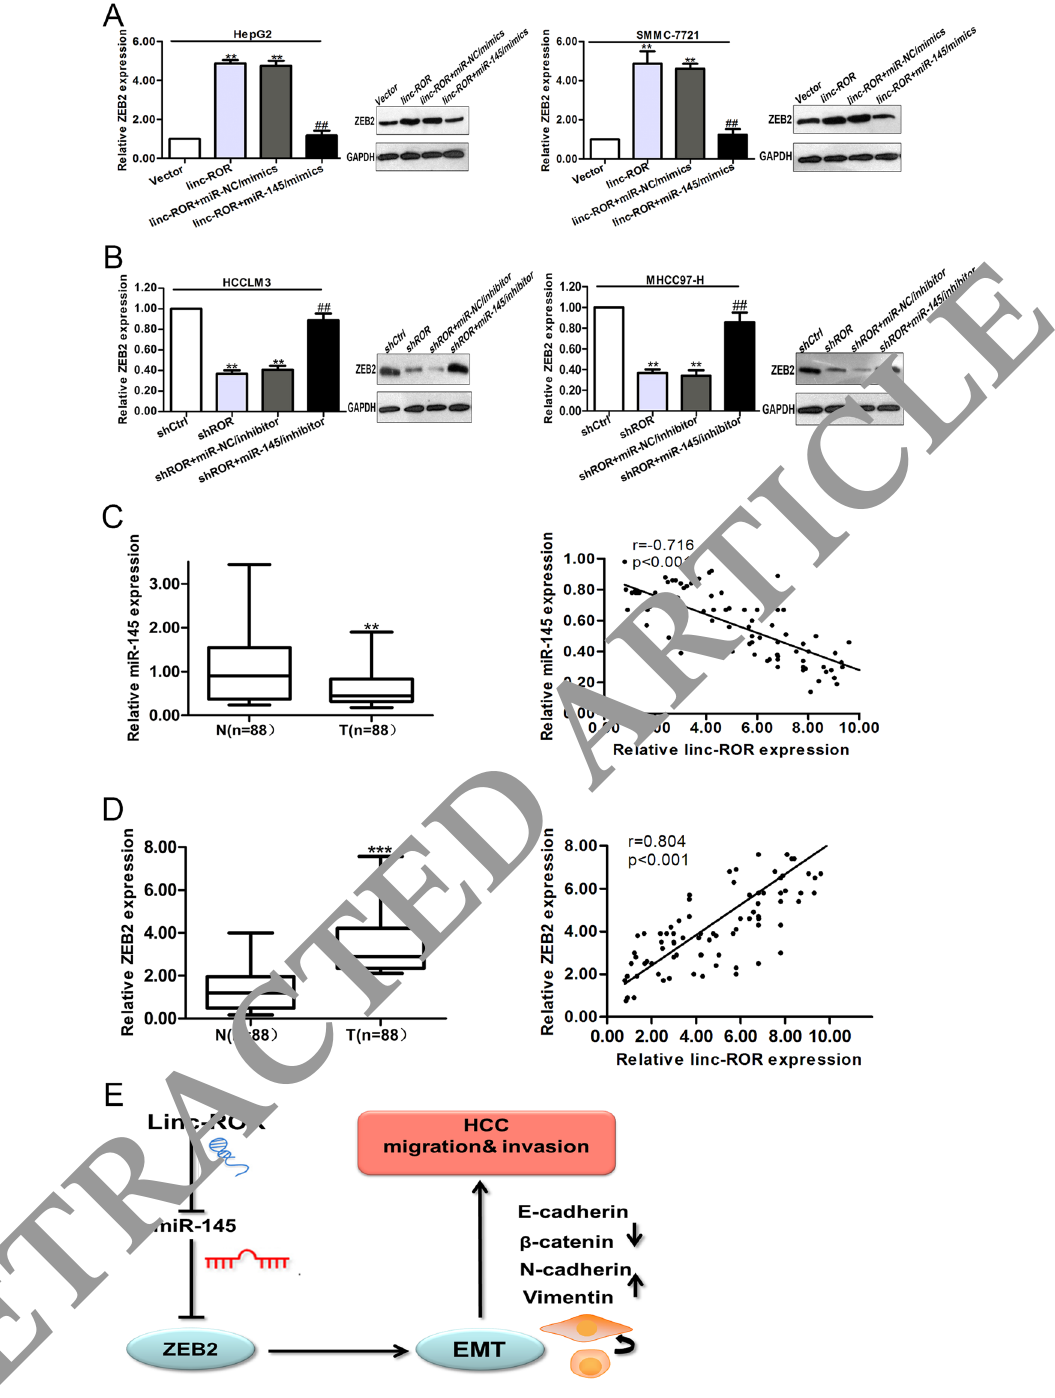
Figure 7. Linc-ROR acts as a ceRNA for ZEB2 by releasing miR-145 in HCC cells. ( A ) qRT-PCR and Western blotting assays were performed to detect the mRNA and protein levels of ZEB2 after cells transfected with linc- ROR and miR-145/mimics. ** p < 0.01 vs . Vector group; ## p < 0.01 vs . linc-ROR + miR-NC/mimics group. ( B ) qRT-PCR and Western blotting assays were performed to detect the mRNA and protein levels of ZEB2 after cells transfected with shROR and miR-145/inhibitor. ** p < 0.01 vs . shCtrl group; ## p < 0.01 vs . shROR + miR-NC/ inhibitor group. ( C ) qRT-PCR detection of miR-145 expression in HCC and adjacent nontumor liver tissues (p < 0.01), showing negative correlation between linc-ROR and miR-145 expression levels in HCC tissues (Spearman’s correlation, r = − 0.716, p < 0.01). ( D ) The expression of ZEB2 in paired samples of primary HCC and adjacent nontumor liver tissues, showing positive correlation between ROR expression and ZEB2 expression in HCC tissues (Spearman’s correlation, r = 0.804, p < 0.01). ( E ) Schematic overview of linc-ROR regulatory signaling. T: HCC tissues; N: nontumor liver tissues. Data are presented as mean ± SD from three independent experiments. *** p <